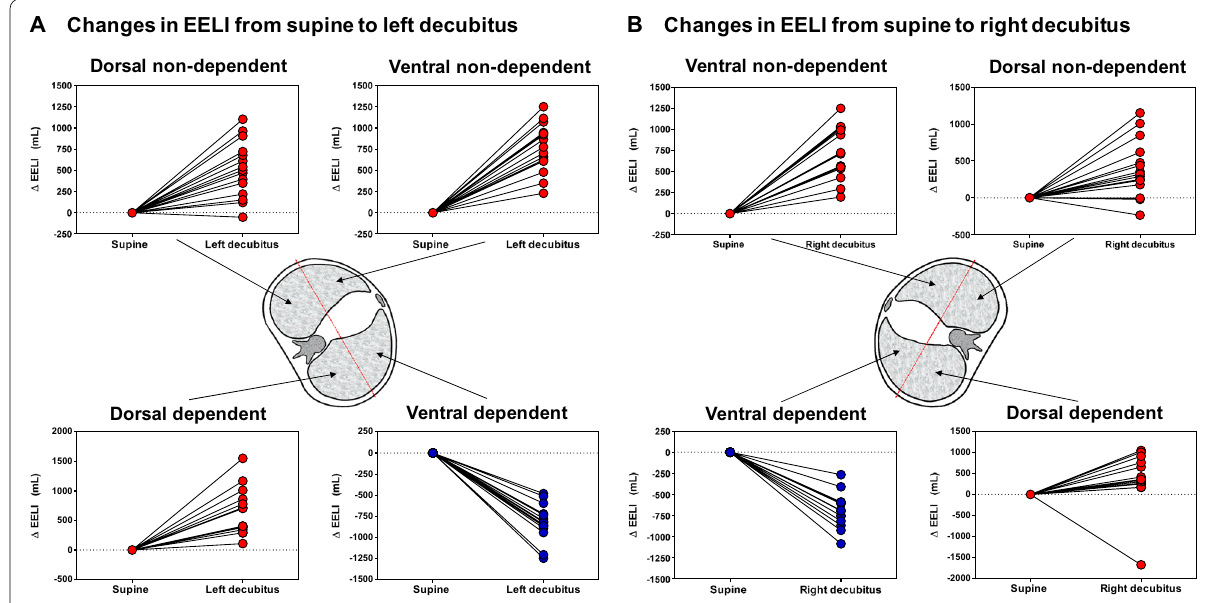
Fig. 4 Changes in the end‑expiratory lung impedance when going from supine to lateral position. Changes in end‑expiratory lung impedance are presented, segmenting the lung into four quadrants from supine to left decubitus (left panel, A ) and from supine to right decubitus (right panel, B ). Regardless of the lateralized side, it is observed a decrease of EELI in the ventral quadrant of the lung placed down (dependent lung) and a significant increase in the other three quadrants. Δ EELI End‑expiratory lung impedance change. Data are shown as mean = ±